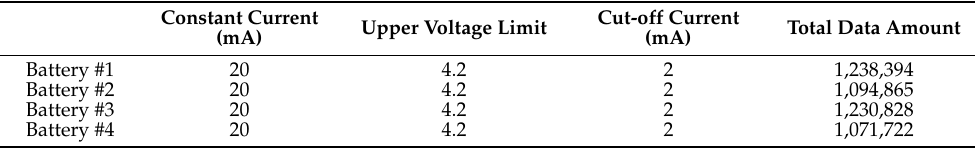
Table 3. Charging Conditions and Amount of Data